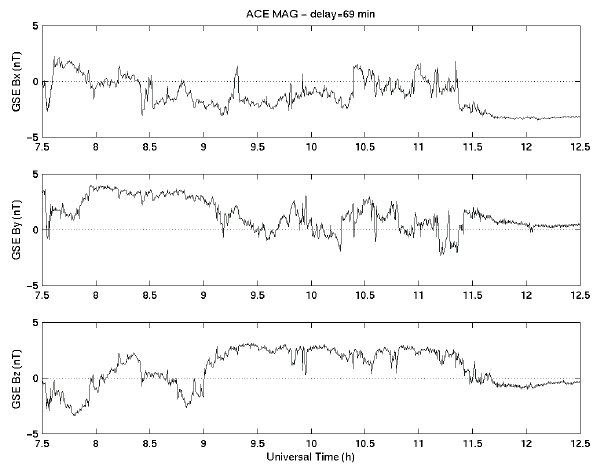
Fig. 3. IMF in GSE coordinates measured by ACE. Data lagged by